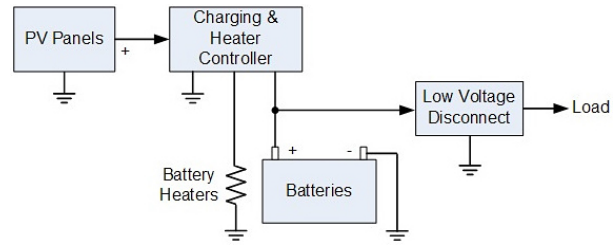
Figure 7. Power system block